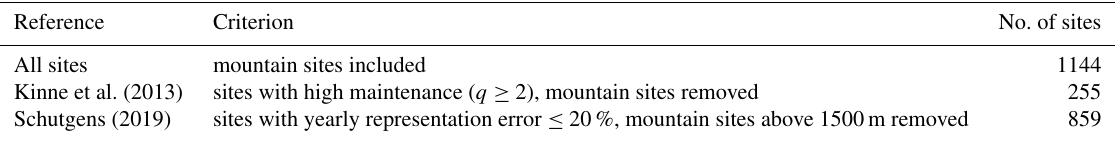
Table 3. AERONET site subsets.